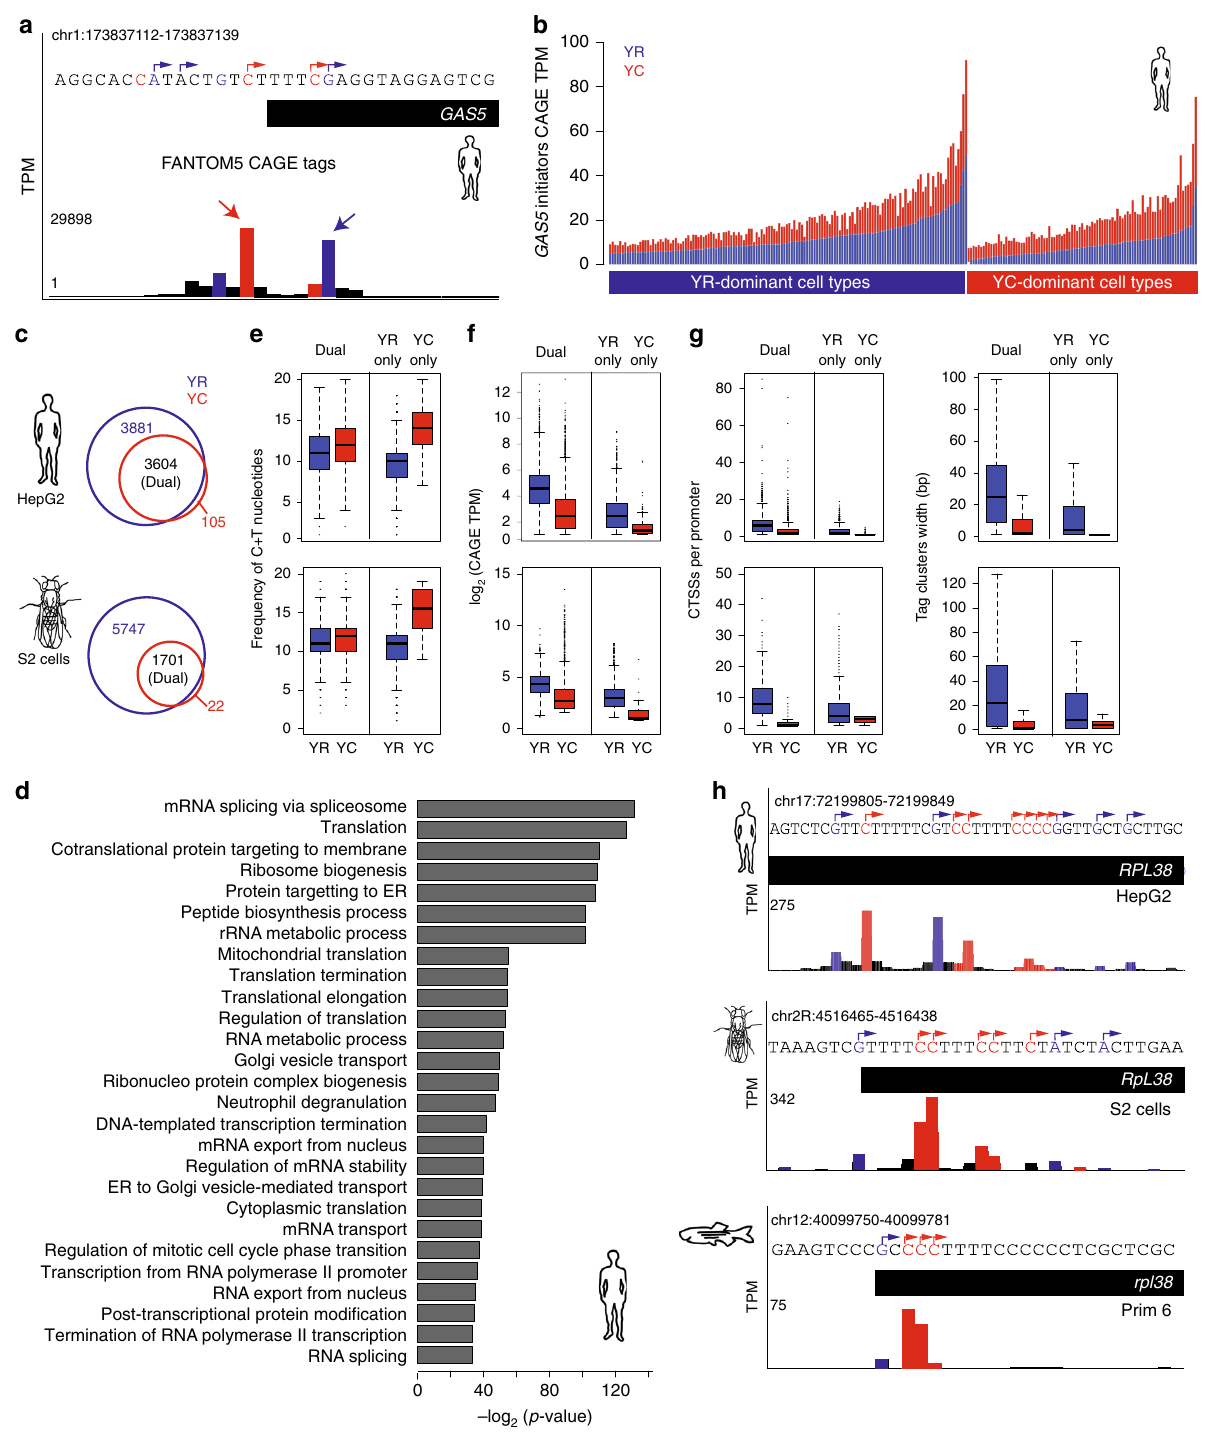
Fig. 7 Dual-initiation (DI) promoters are conserved in human and Drosophila . a A UCSC browser screenshot of human GAS5 promoter CAGE data (summed CTSSs) in FANTOM5 cell types. CTSSs show transcription of YR-initiation and YC-initiation within same core promoter region. b Expression levels of YR-initiations and YC-initiations by summing their CTSSs. Promoter are classi fi ed as YR-dominant or YC-dominant across individual cell types and their expression is shown in stacked bars. Y -axis shows the expression levels measured in tags per million (TPM). c Venn diagram with intersection of gene promoters with YR and YC-initiation in human HepG2 and Drosophila S2 cells. DI promoters are indicated in the overlap between detected YR-initiation and YC-initiation. d Enrichment of gene ontology terms of DI promoters in human HepG2 cell line. e Comparison of C + T sequence content around transcription start sites in DI promoters with YR-only or YC-only initiation promoter in human and drosophila. f Expression levels of DI promoter genes in human and Drosophila . g Frequency of CTSSs and promoter width of DI promoters in human and Drosophila . h UCSC browser screenshots showing CTSSs in the promoter region of RPL38 gene in human, Drosophila and zebra fi sh. YR-initiation and YC-initiation peaks are colored as blue and red. Boxplots show the 5th, 25th, 50th, 75th, and 95th percentiles where center line is the